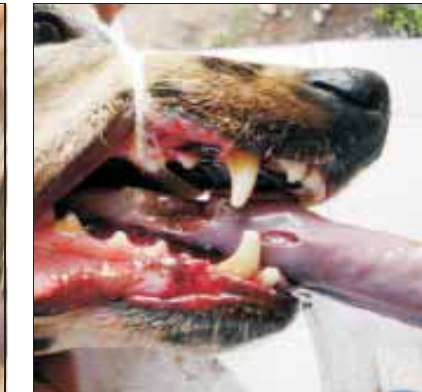
Figure-3: Periodontitis (moderate) ex- cessive wearing and increased mobility of teeth Table-3: Haematological changes in dogs with kidney dysfunction Parameters